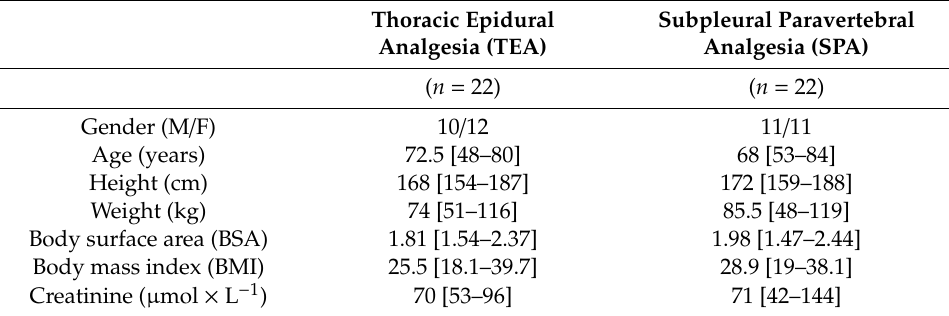
Table 2. Characteristics of the groups, demographic data.